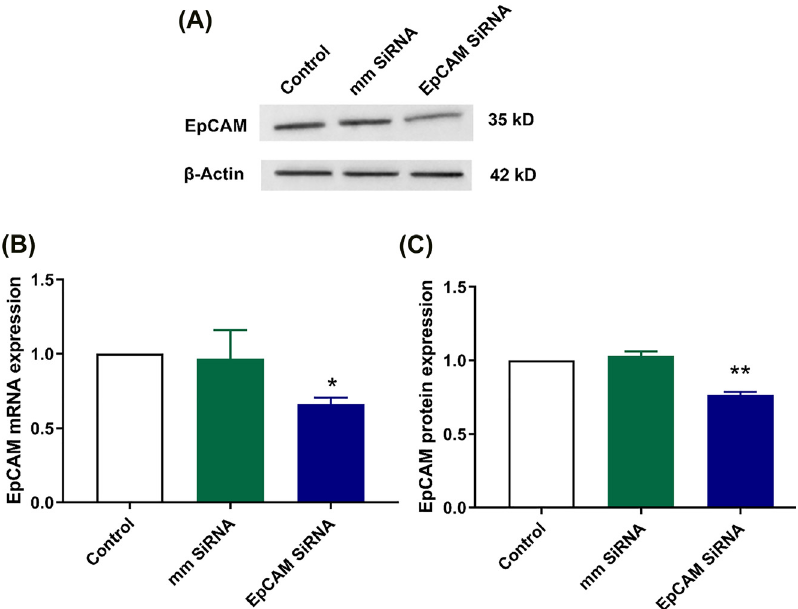
Figure 2: The EpCAM silencing efficacy in the EpCAM high /CD44 + HCT116 cells(A) Western blot analysis of EPCAM level in the EpCAM high /CD44 + HCT116 cells treated with control, mm siRNA or EpCAM siRNA (B) semi-quantitative analysis of EpCAM mRNA levels detected by real-time RT-PCR analysis and (C) semi-quantitative analysis of EpCAM protein levels detected by Western lotting. *p<0.05, **p<0.01 vs. control